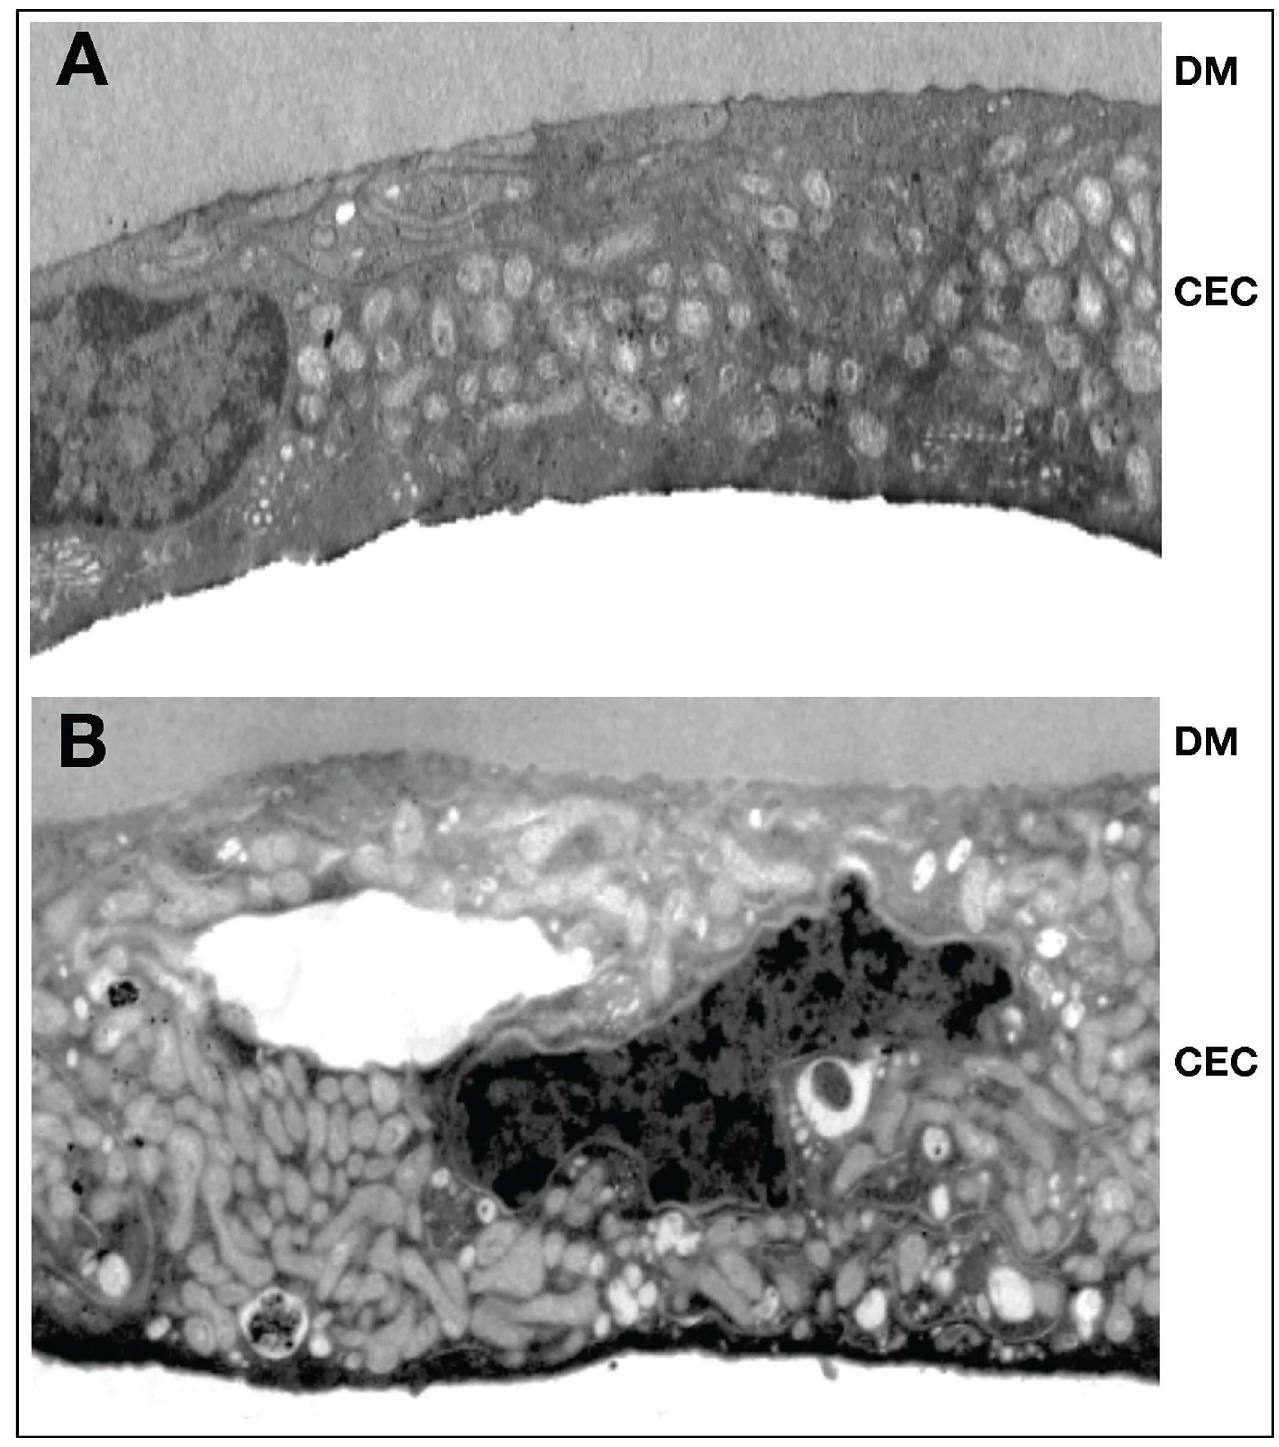
Fig 1. Corneal endothelial cell morphology. Corneal endothelial cells without diabetes (A; control) and with diabetes (B). The cells in diabetic corneas are distended and have altered appearing mitochondria, dark inclusion bodies, a dark apical surface, a greater number of vacuole type bodies, and altered golgi compared to control tissues. The dark appearance of the inclusion bodies–within organelles and the cytosol, as well as on the apical surface–indicates aggregates of possible protein and lipid waste. Mitochondrial and golgi alterations were consistent among all affected samples and indicate potential changes in organelle dynamics in disease states. DM, Descemet membrane; CEC, corneal endothelial cell.